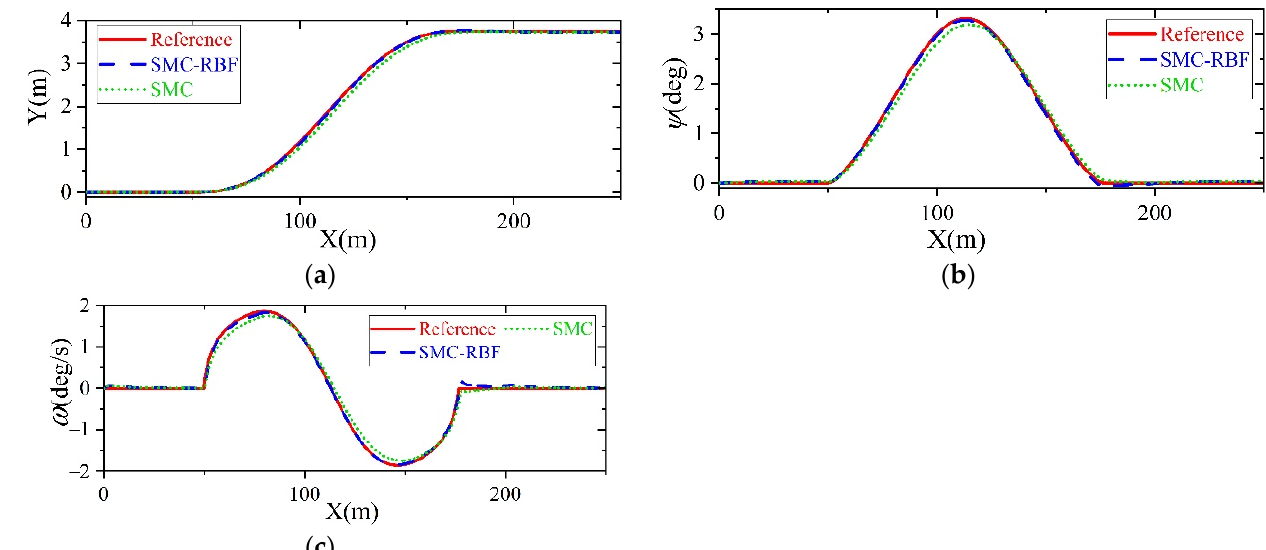
Figure 8. Comparison of path following controller with and without angle compensation control. ( a ) Comparison of driving path. ( b ) Comparison of heading angle. ( c ) Comparison of yaw rate.